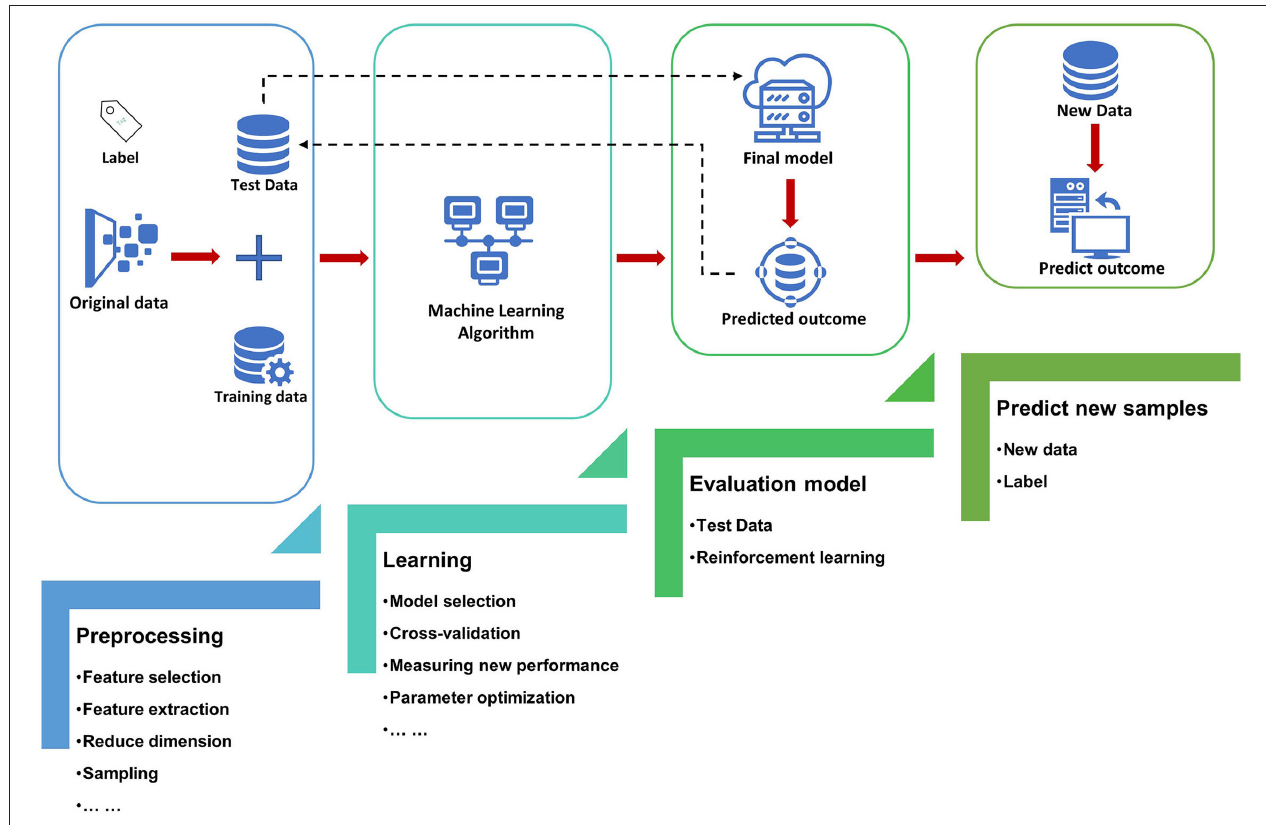
FIGURE 1 | Roadmap for machine learning